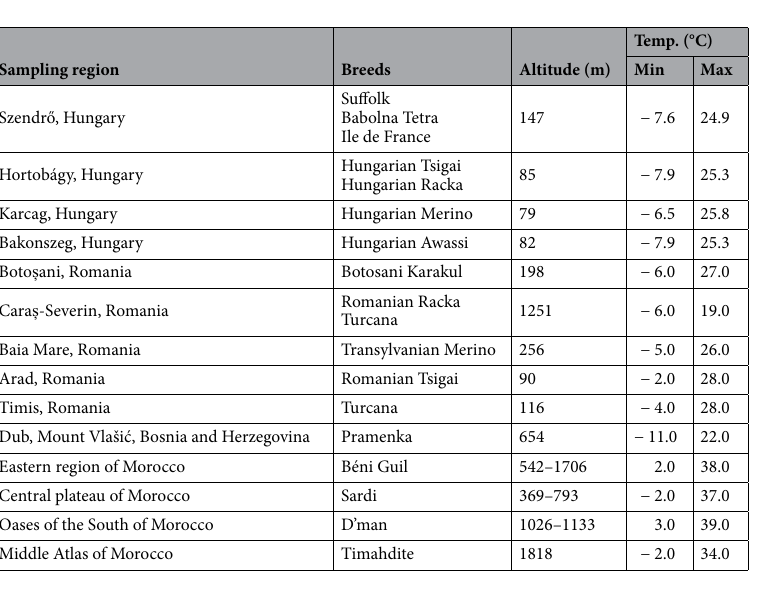
Table 2. Sampling region climatological details.